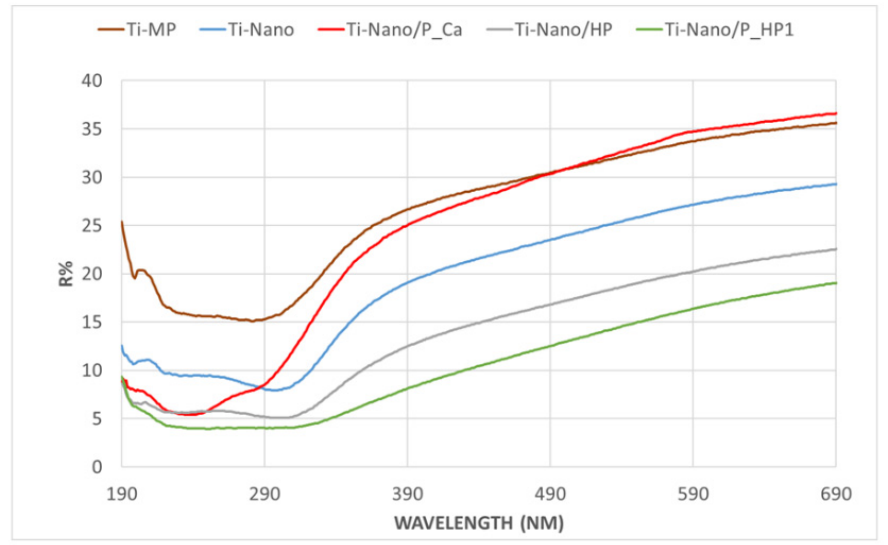
Figure 4. UV–Vis spectra of Ti-MP, Ti-Nano, Ti-Nano/HP, Ti-Nano/P_Ca, and Ti-Nano/P_HP1. Ti_Nano/HP has a spectrum with even lower reflectance than Ti_Nano because a layer of amino acids from the medium is adsorbed on the surface oxide layer due to the soaking in the high–amino acid